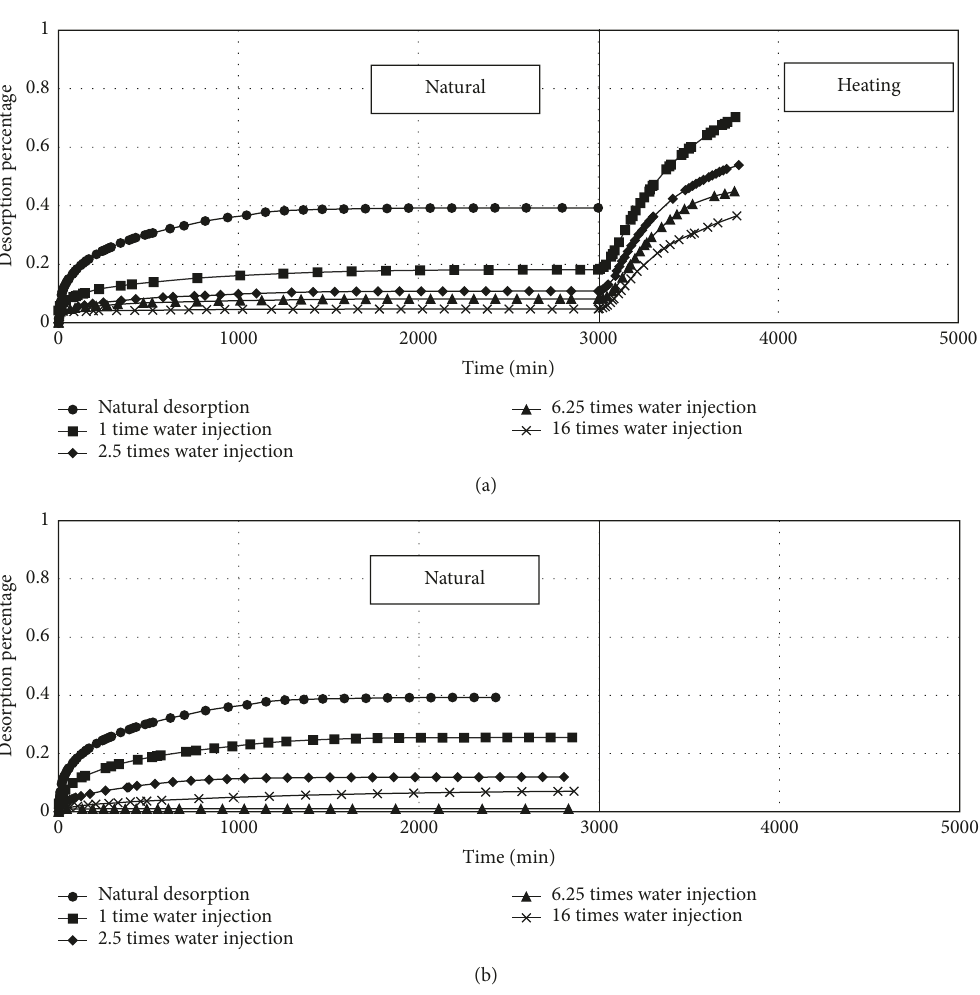
Figure 4: Desorption capacity versus time in different water injection pressures around 0.50MPa gas adsorption pressure. (a) Coal sample #1 (Gucheng Coal Mine). (b) Coal sample #2 (Gaohe Coal